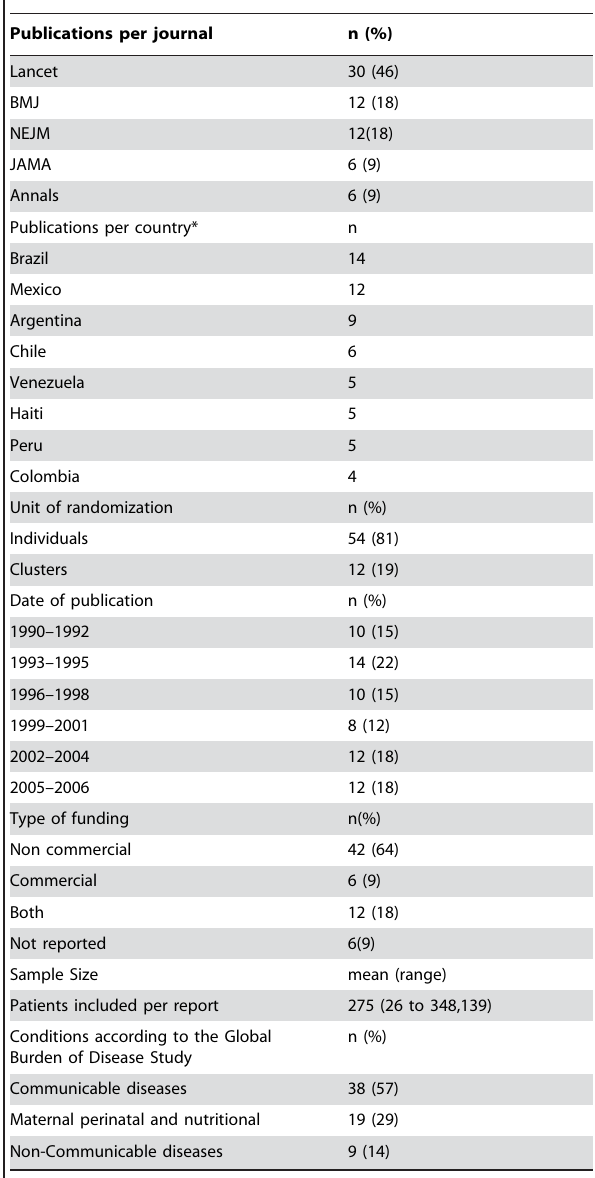
Table 1. General Characteristics of the reports